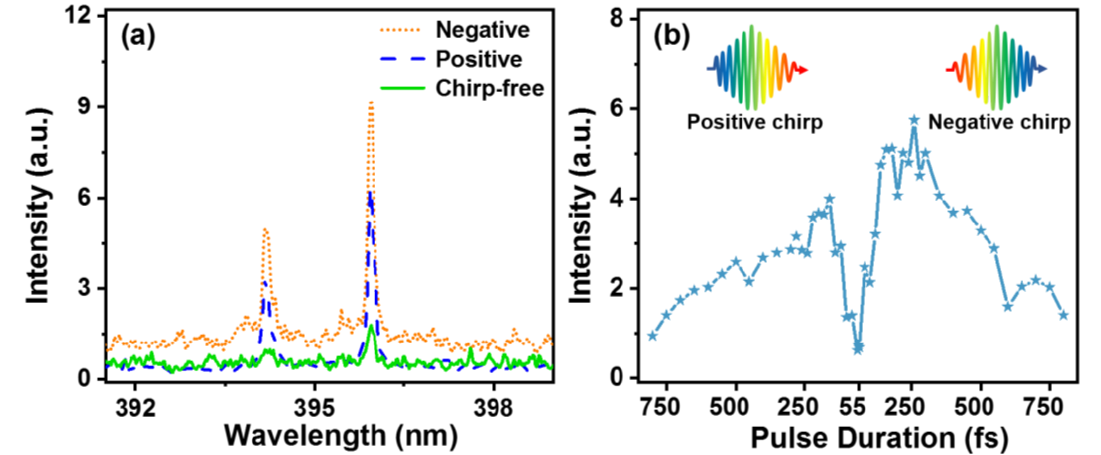
Figure 2. ( a ) FIBS emission spectra obtained respectively by a chirp-free 55 fs (solid), a negatively chirped 200 fs (dotted dash), and a positively chirped 200 fs (dash) pulse; ( b ) FIBS intensities of Al atoms at 396.2 nm obtained with different pulse durations under the negative chirp and positive chirp conditions.